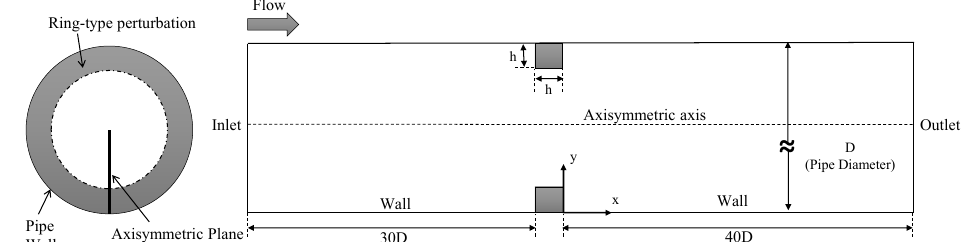
Figure 2. Cross-sectional schematics of the computational domain (not to scale).